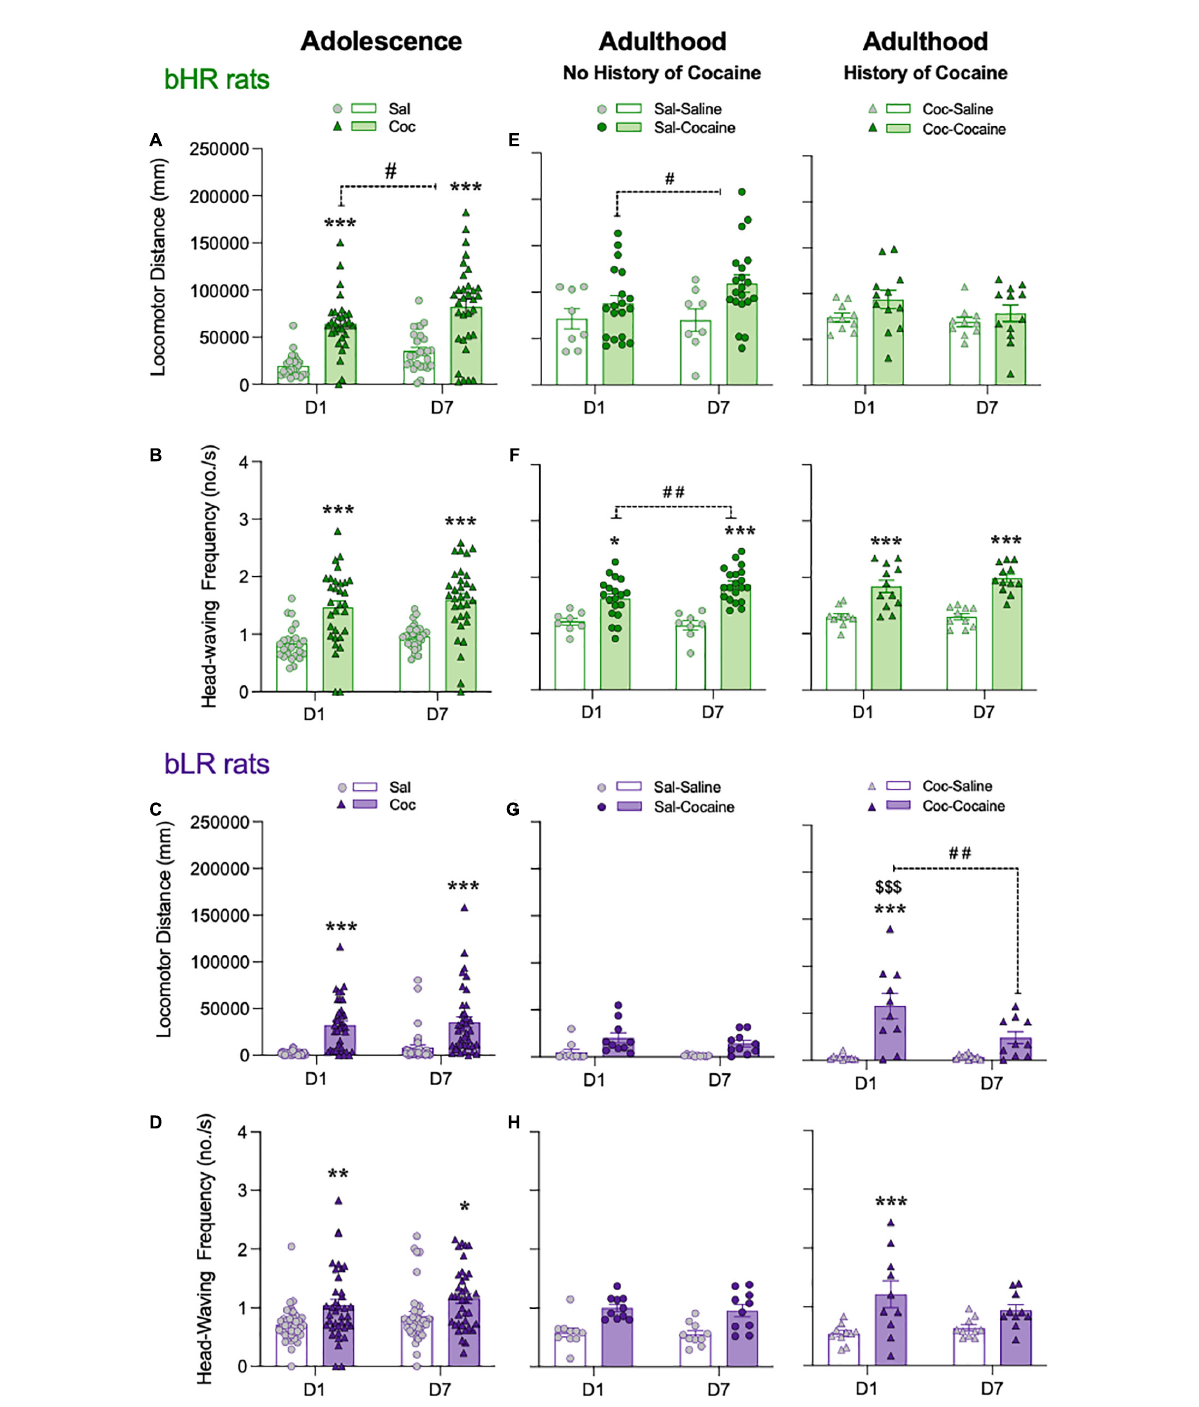
FIGURE3 Adolescent cocaine differentially impacts psychomotor sensitization in divergent affective phenotypes. Acute (D1) and chronic (D7) psychomotor activating effects of cocaine administration in adolescent (A–D) and/or in adulthood [with no or with a prior history of adolescent cocaine; (E–H) ] in bHR and bLR rats. Data represents the mean values ± SEM of the locomotor distance traveled in mm (A,C,E,G) and the frequency of head-waving (B,D,F,H) . Individual values are shown for each rat (symbols). Two- or three-way RM ANOVAs were used for statistical analysis (see Supplementary Table 1 for more details). * p < 0.05, ** p < 0.01 and *** p < 0.001 when comparing cocaine-treated rats with the corresponding saline-treated group (main Effect of Treatment). ## p < 0.01 and # p < 0.05 when comparing D7 vs. D1 responses for the